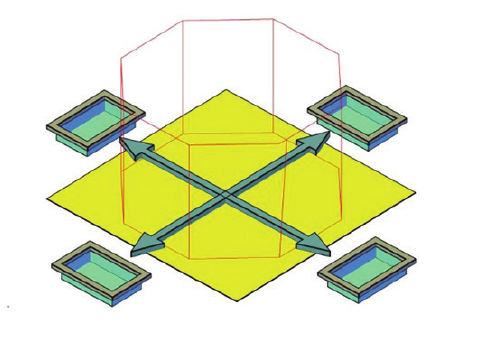
Figure 5. Kallegi pools (source: